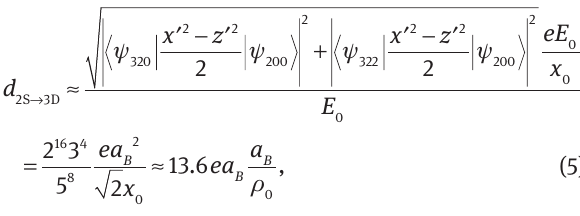
the red line B and the distance 0